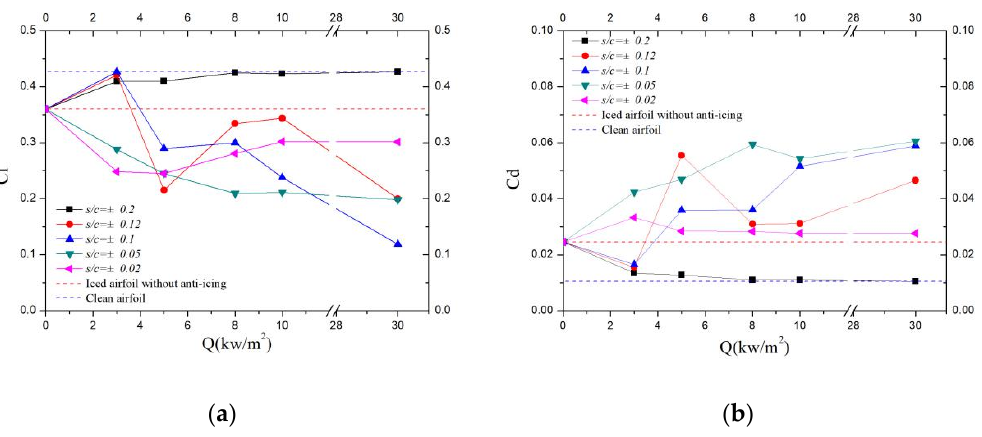
Figure 9. Aerodynamic characteristics of airfoil after icing: ( a ) Cl; ( b ) Cd.